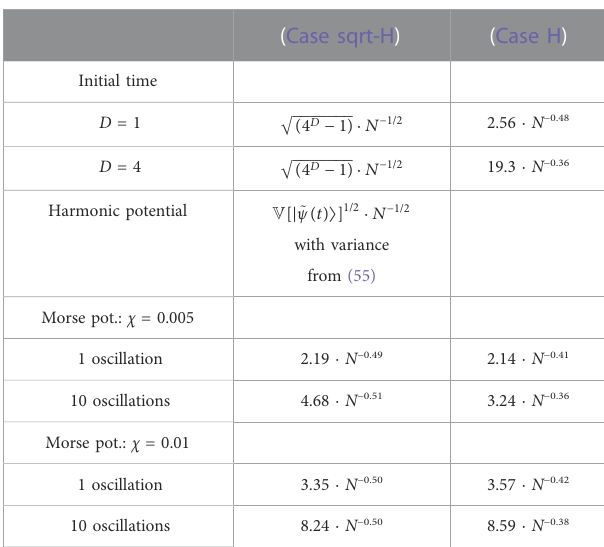
TABLE 1 Summary of convergence rates for (Case sqrt-H) and (Case H) at initial time, in a harmonic oscillator and in two Morse potentials after one and ten